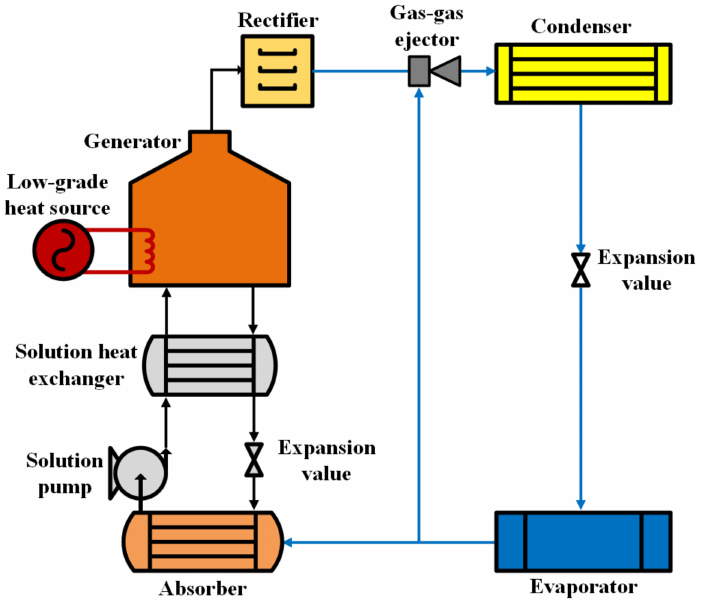
Figure 4. Schematic diagram of Hybrid Ejector-Absorption Refrigeration System (HEARS), Low- pressure condenser “LPC”